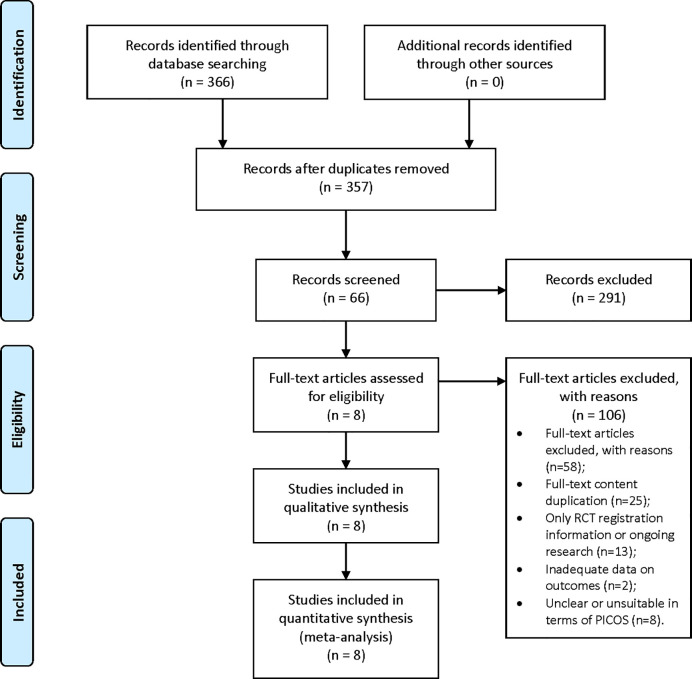
Flow diagram of study selection.